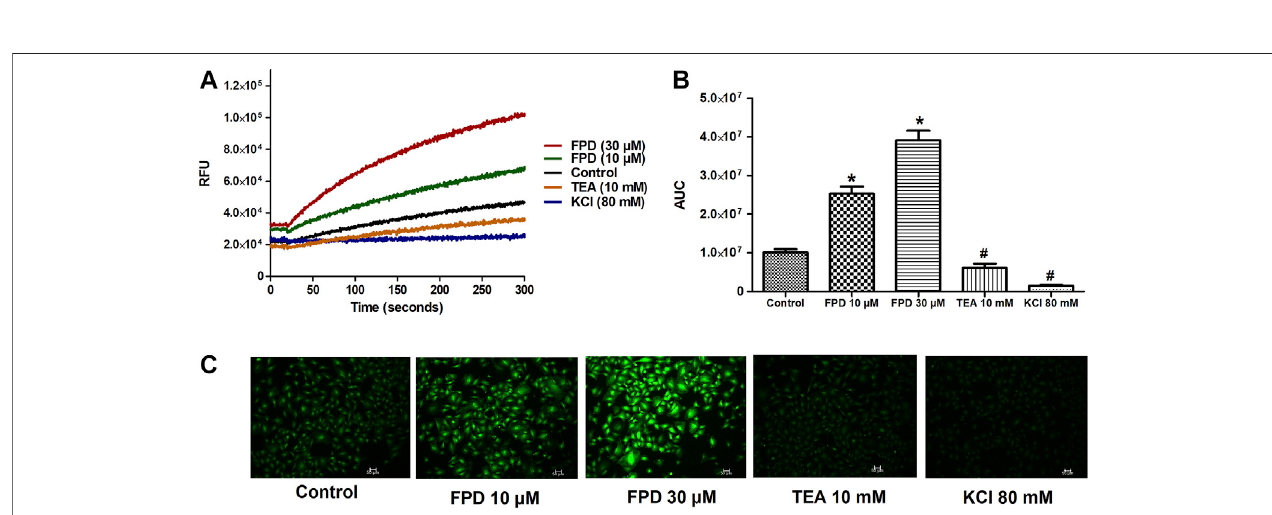
FIGURE 7 | Representative traces of intracellular K + concentration stimulated/inhibited by FPD (10 µM), FPD (30 µM), TEA (10 mM), and KCl (80 mM) in rat aortic VSMC loaded with FluxOR II Green (A) . (B) depicts the area under the curve (AUC; * signi fi cantly increased compared to control; # signi fi cantly decreased compared to control; n (cid:2) 10). C shows the representative images of the